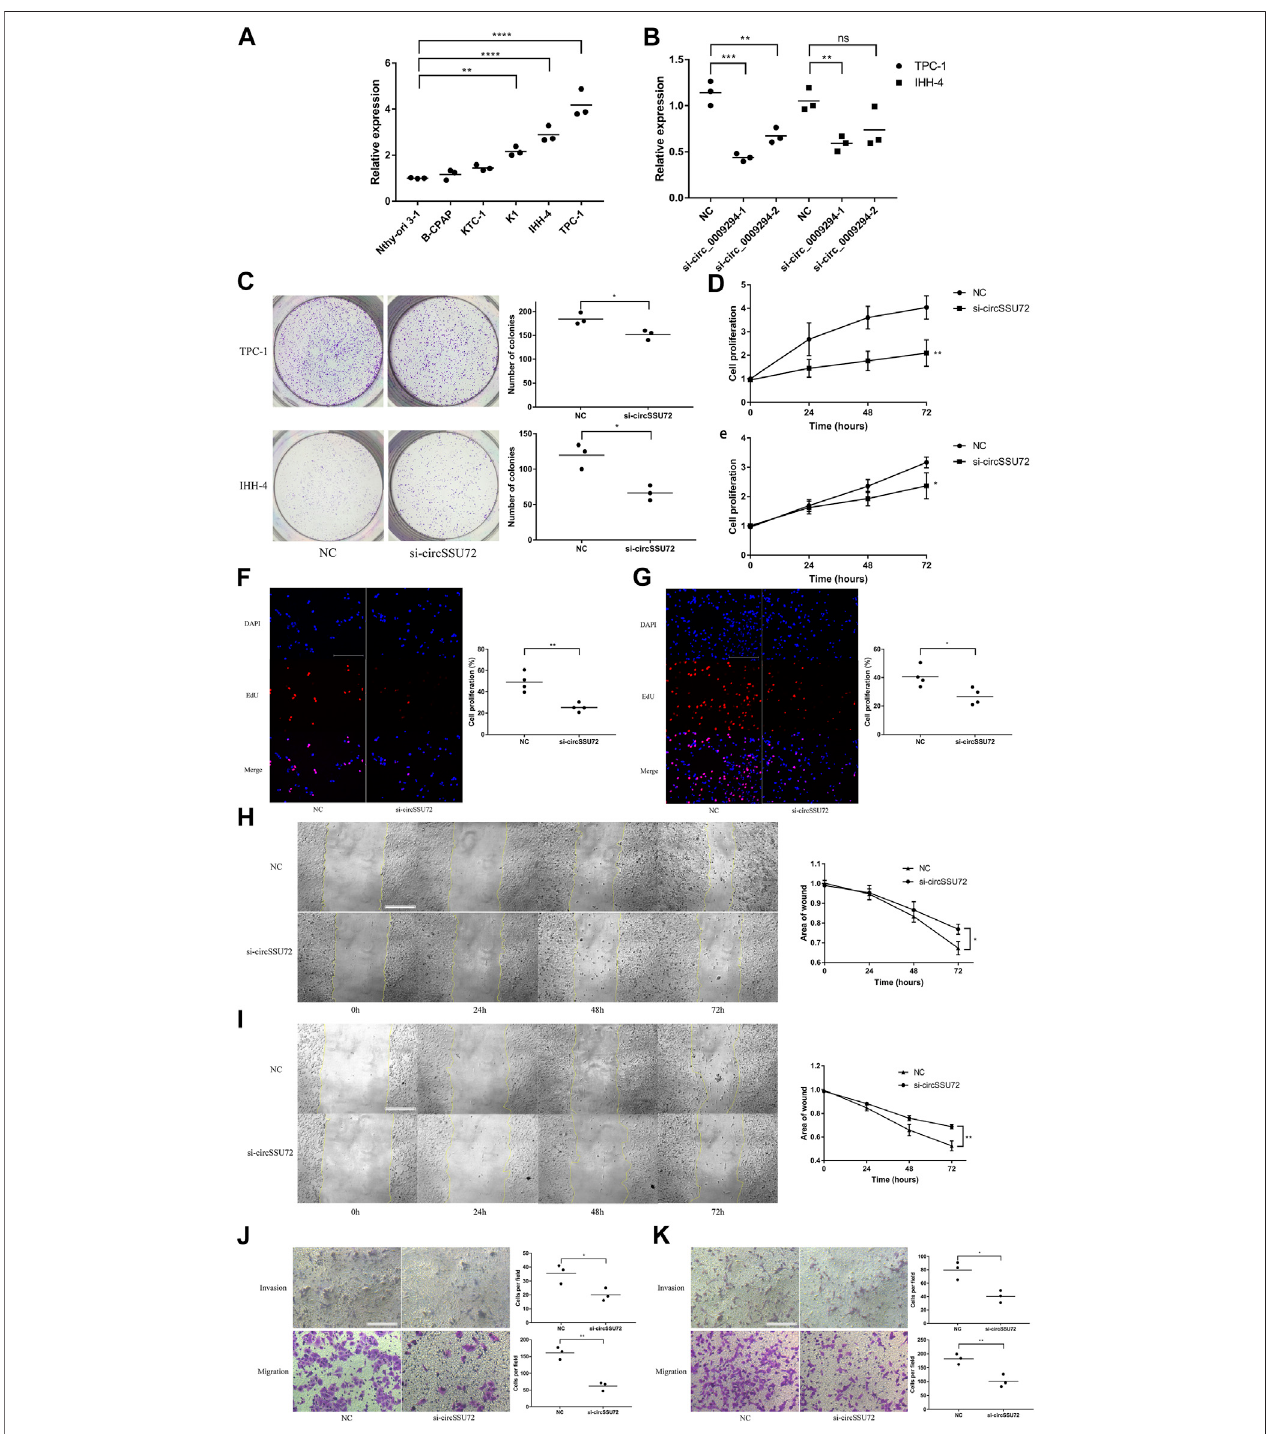
FIGURE2| ThesilenceofcircSSU72inhibitedPTCcellproliferation,migration,andinvasion. (A) TheexpressionofcircSSU72wasinvestigatedin fi vePTCcelllines ( n =3). (B) TPC-1andIHH-4cellsweretransfectedwithsiRNAsofcircSSU72,andtheexpressionlevelofcircSSU72wasanalyzedbyqRT-PCRassay( n =3). (C) Colony formation assay of the cell proliferation ability in TPC-1 and IHH-4 cells transfected with si-circSSU72 ( n = 3). (D) CCK8 assay to assess the in fl uence of circSSU72 on TPC-1 cell ( n = 3). (E) CCK8 assay to assess the in fl uence of circSSU72 on IHH-4 cell ( n = 3). (F) EdU assay of the cell proliferation ability in TPC-1 cell transfected with si-circSSU72 (scale bar = 100 um, n = 4). (G) EdU assay of the cell proliferation ability in IHH-4 cell transfected with si-circSSU72 (scale bar = 100 um, n = 4). (H) Scratchwound healingassaysin transfectedTPC-1 cell (scale bar =200 um, n = 3). (I) Scratchwound healingassaysin transfectedIHH-4 cell (scale bar =200 um, n = 3). (J) Transwell invasion and migration assay in transfected TPC-1 cell (scale bar = 100 um, n = 3). (K) Transwell invasion and migration assay in transfected IHH-4 cell (scale bar = 100 um, n = 3). p < 0.05; ** p < 0.01; *** p < 0.001; **** p < 0.0001.